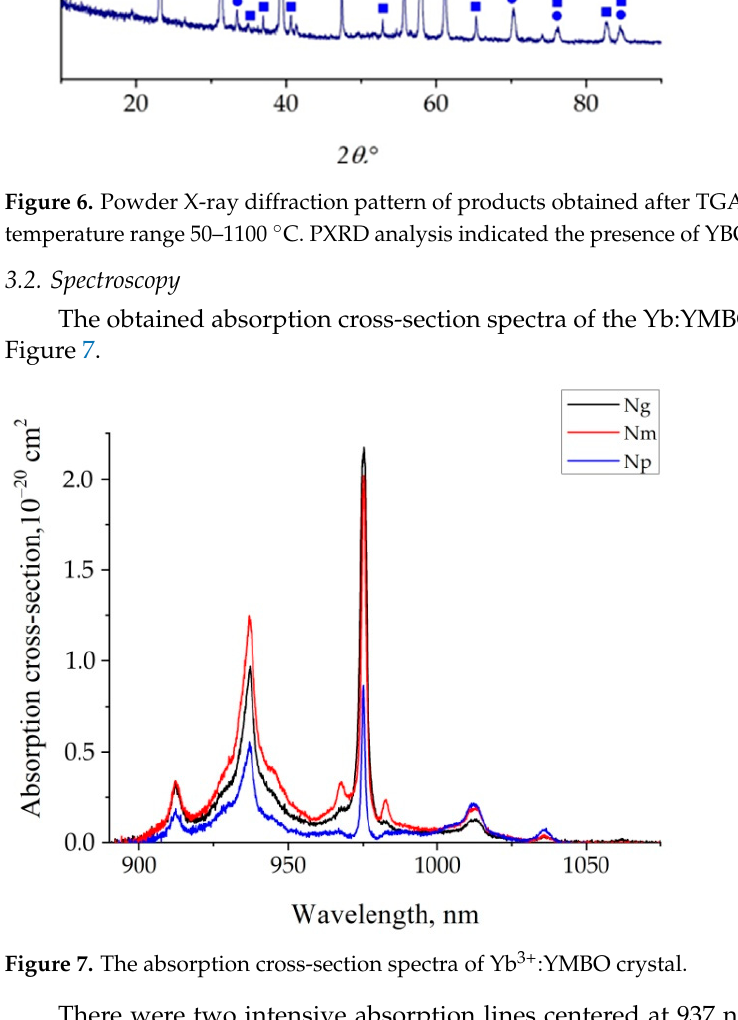
Figure 7. The absorption cross-section spectra of Yb 3+ :YMBO crystal. There were two intensive absorption lines centered at 937 nm and 975 nm. These wavelengths correspond to the emission spectra of commercially available InGaAs laser diodes. The maximal absorption cross-section was 2.15 × 10 − 20 cm 2 at 975 nm for the E//N g axis. The comparatively narrow bandwidth (FWHM) of about 3 nm leads to additional requirements for thermal stabilization of the laser diode pumping. It is to be noted that there was a qualitative difference in the peaks’ intensities in comparison with previously reported absorption spectra